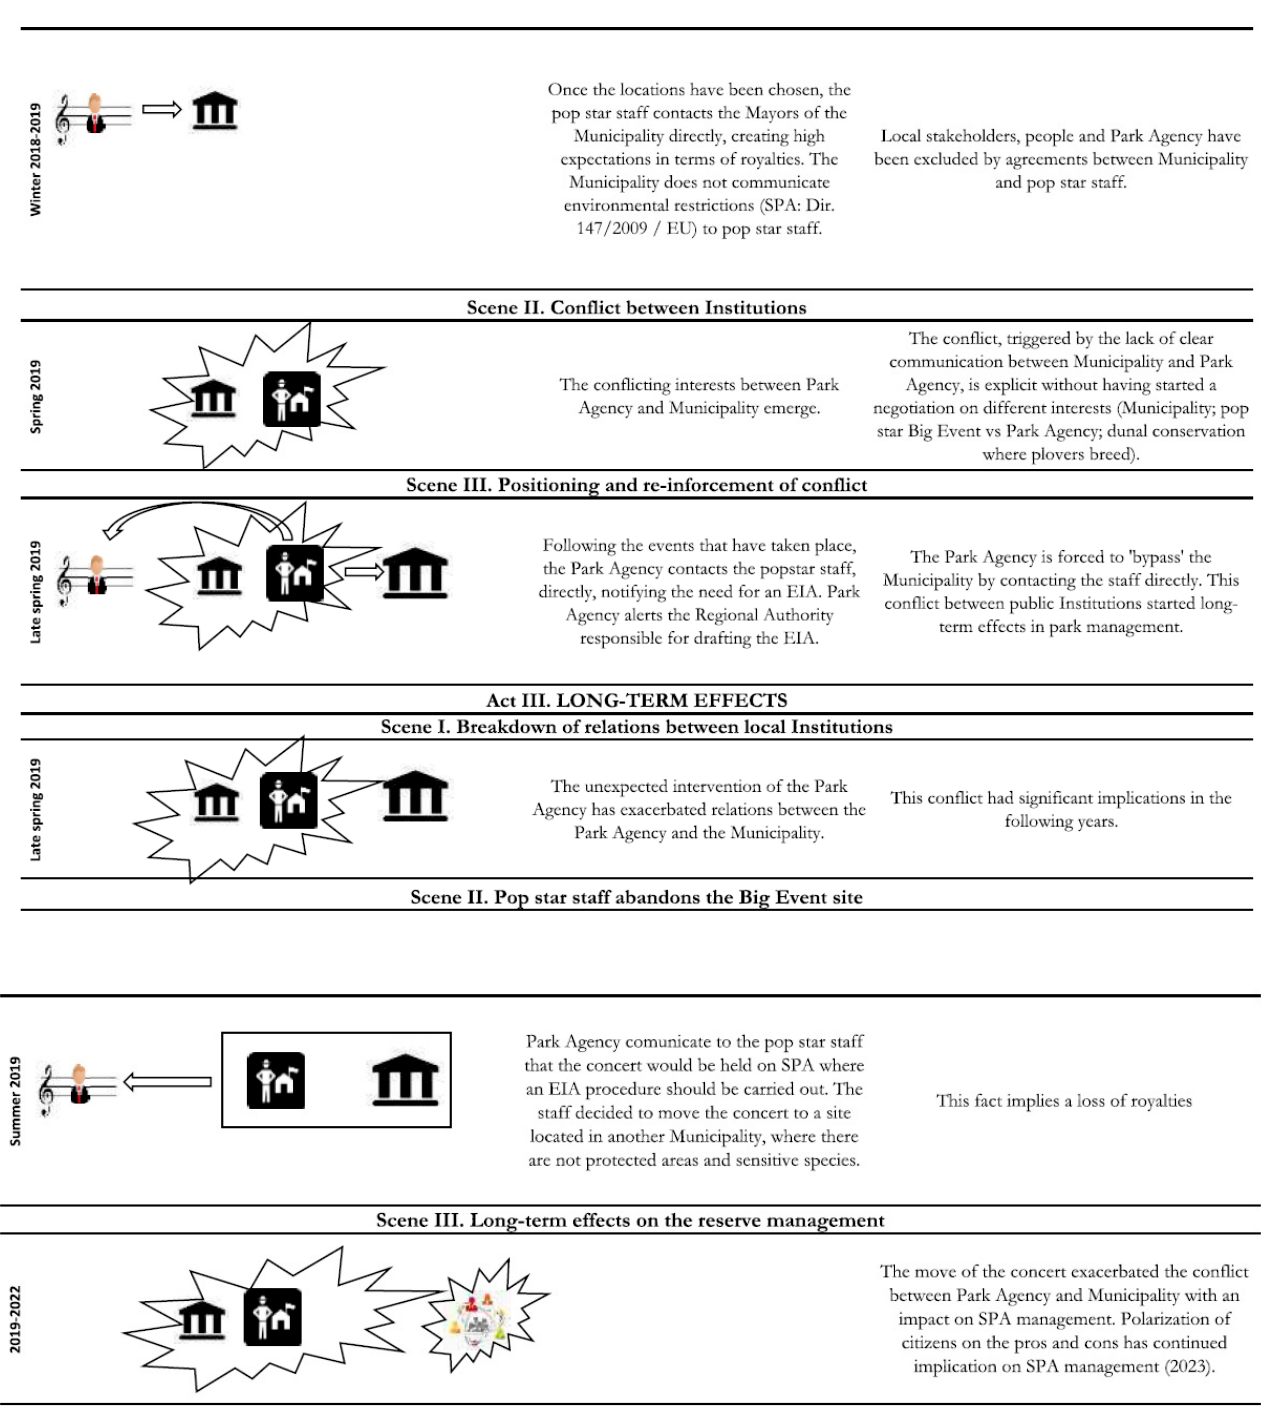
Figure 1. A framework of the conservation drama in three acts (and related scenes) involving a big musical event and two threatened beach-nesting birds (see Methods for details). Boxes: the agreements; lightning: the ‘surprises’; arrows: the relationships between actors; stars: the conflicts.